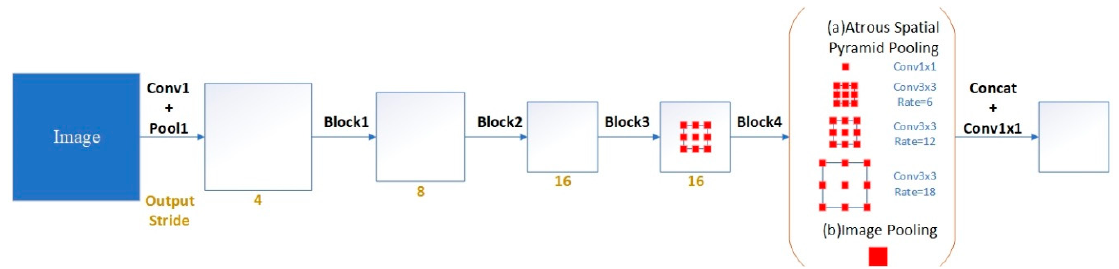
Figure 3. DeepLabv3 network structure diagram used in this study.